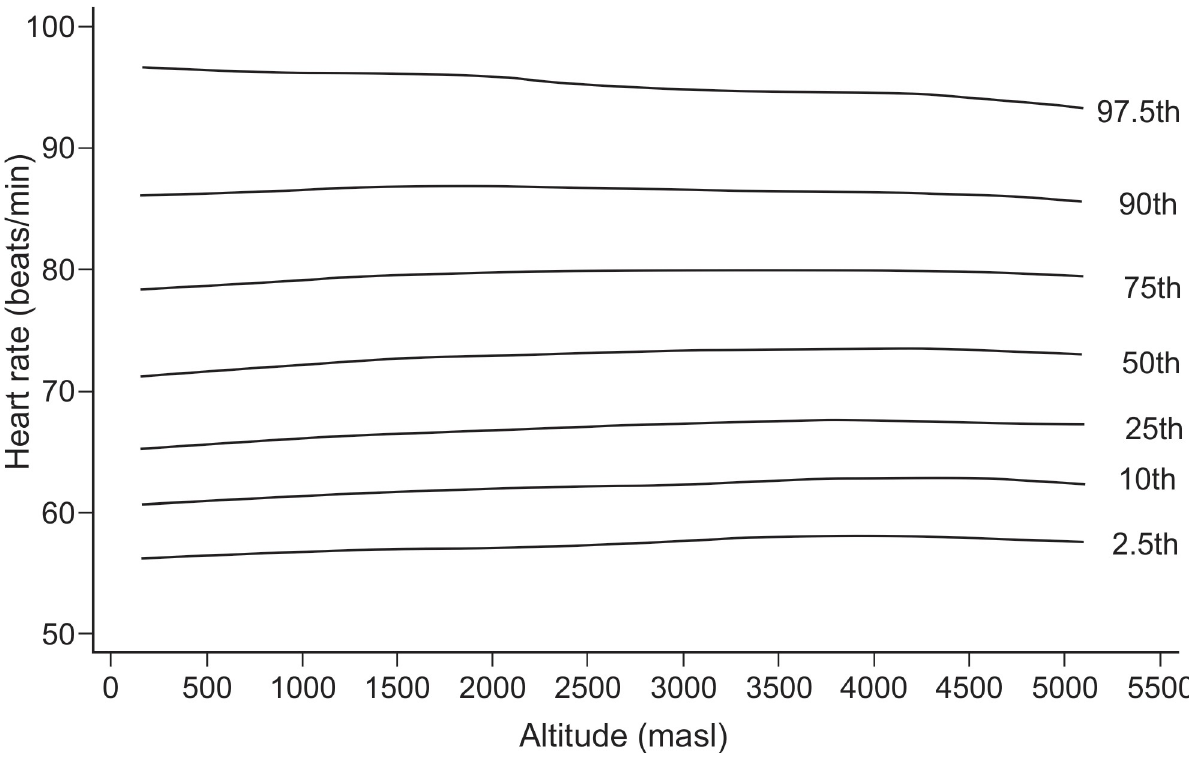
Fig 5. Heart rate at rest according to altitude of residence in Peruvian children and